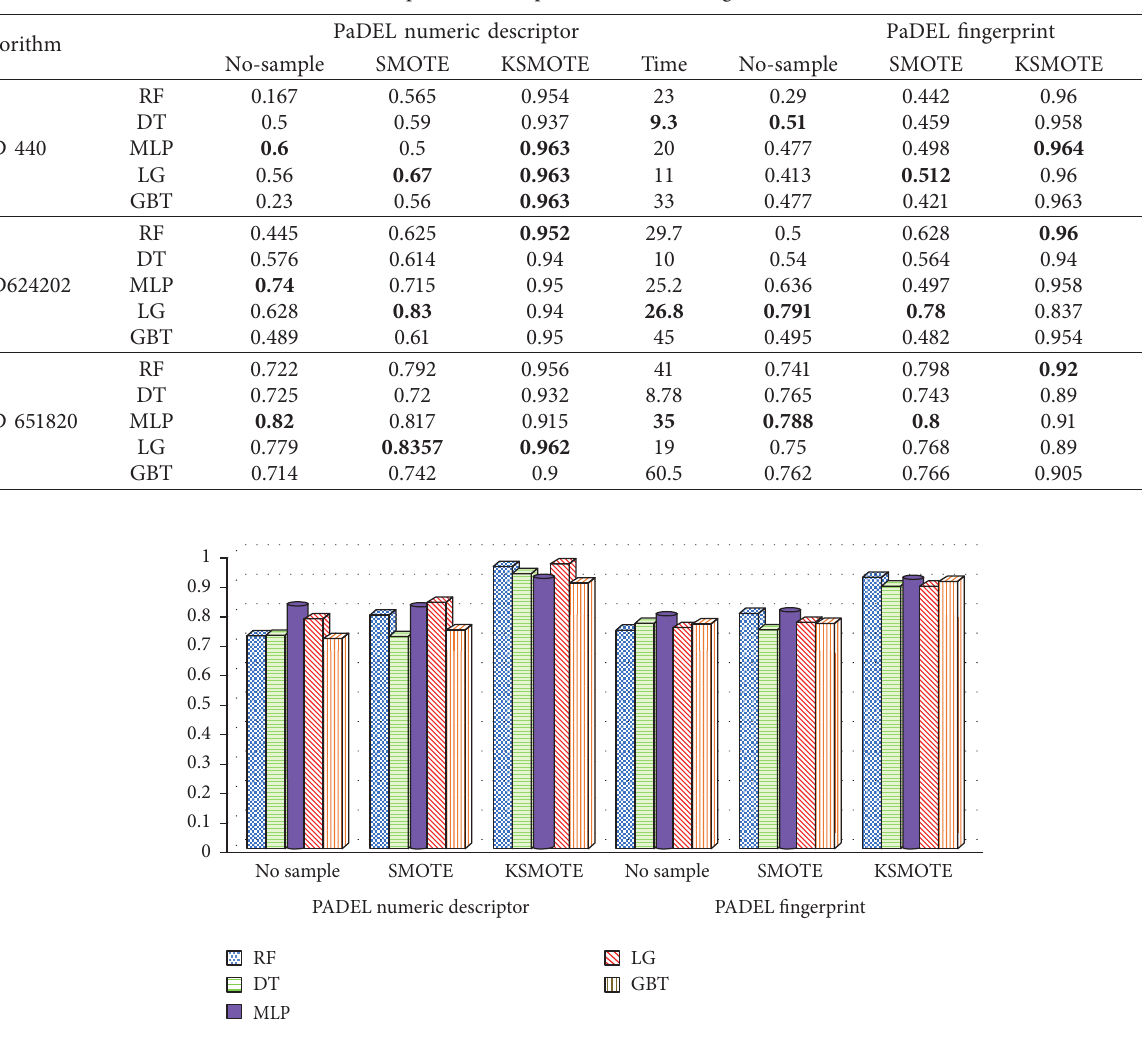
Table 2: Complete set of experiments and average G-mean results.